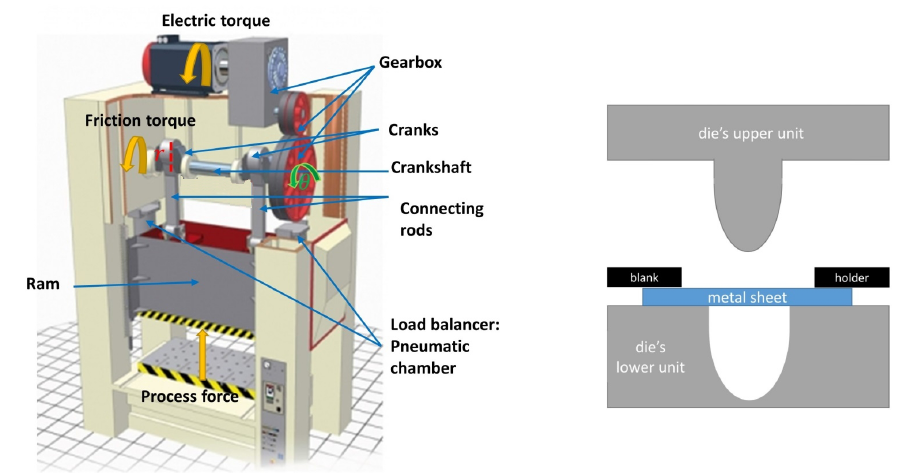
Figure 1. Image of a servo press machine with its main components on the left, and slide and ram scheme on the right